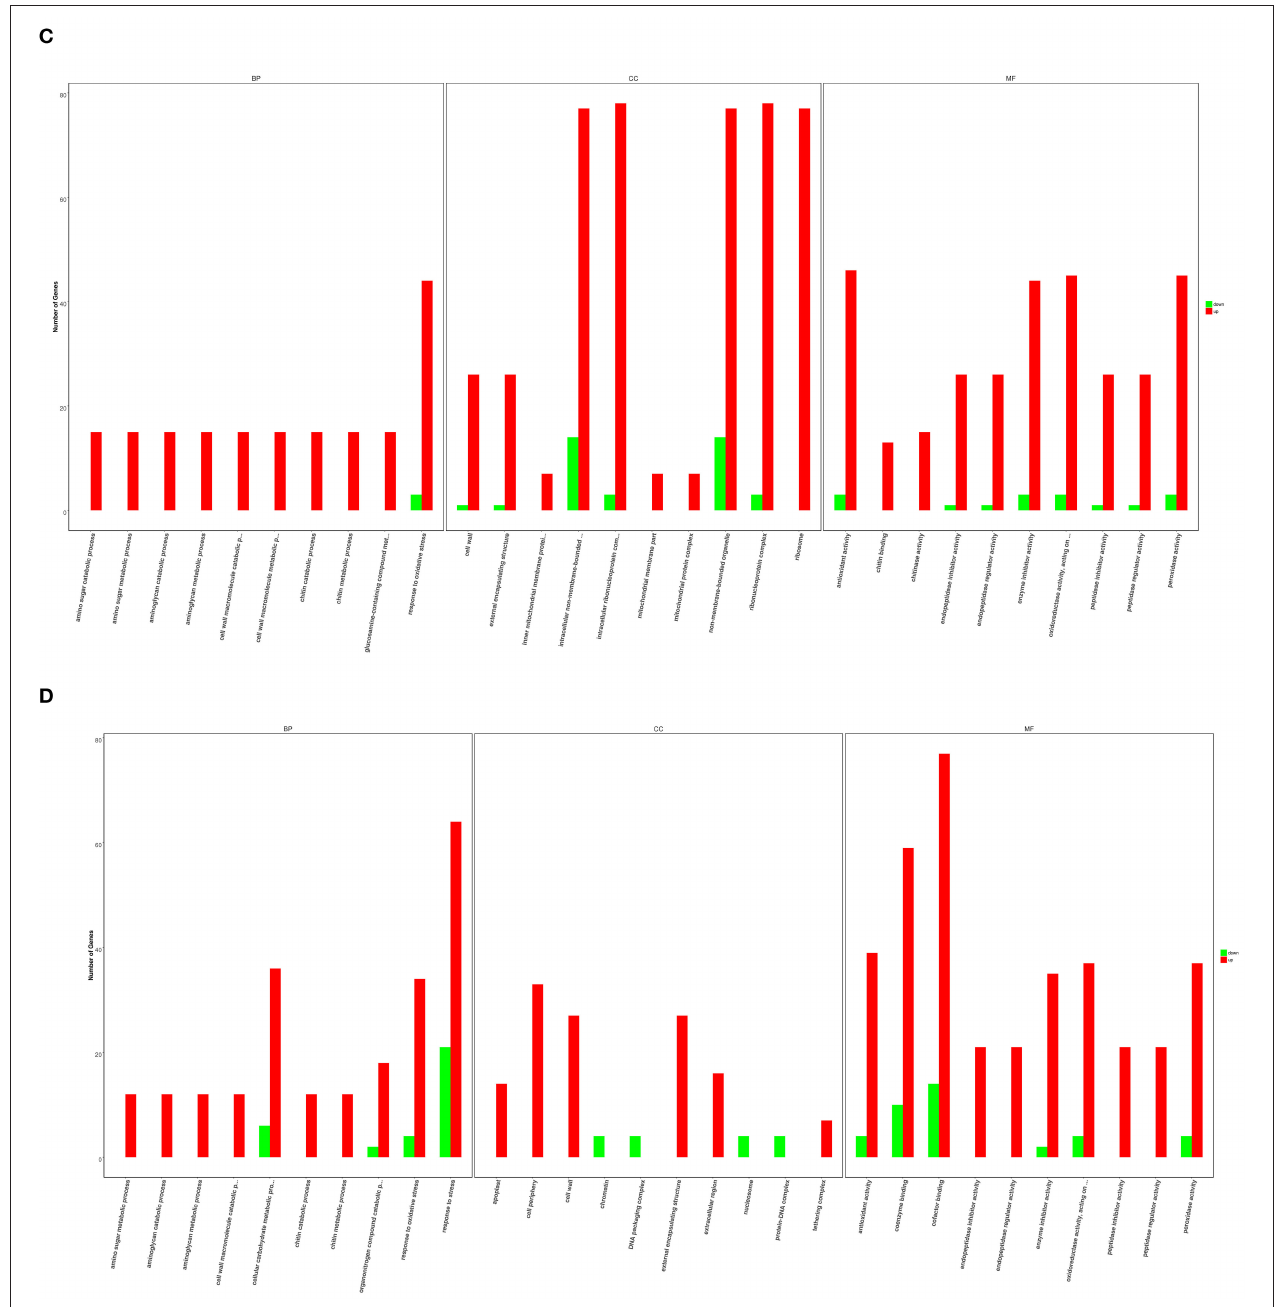
FIGURE 2 | Gene ontology (GO) categories of differentially expressed genes (DEGs) between Fusarium Oxysporum -treated and wild type (WT) Pdpap. (A) T1 and T0. (B) T2 and T0. (C) T3 and T0. (D) T4 and T0. T0, T1, T2, T3, and T4 stand for the F. oxysporum -treated Populus davidiana × P. alba var. pyramidalis Louche (Pdpap) by 0, 6, 12, 24, and 48h,